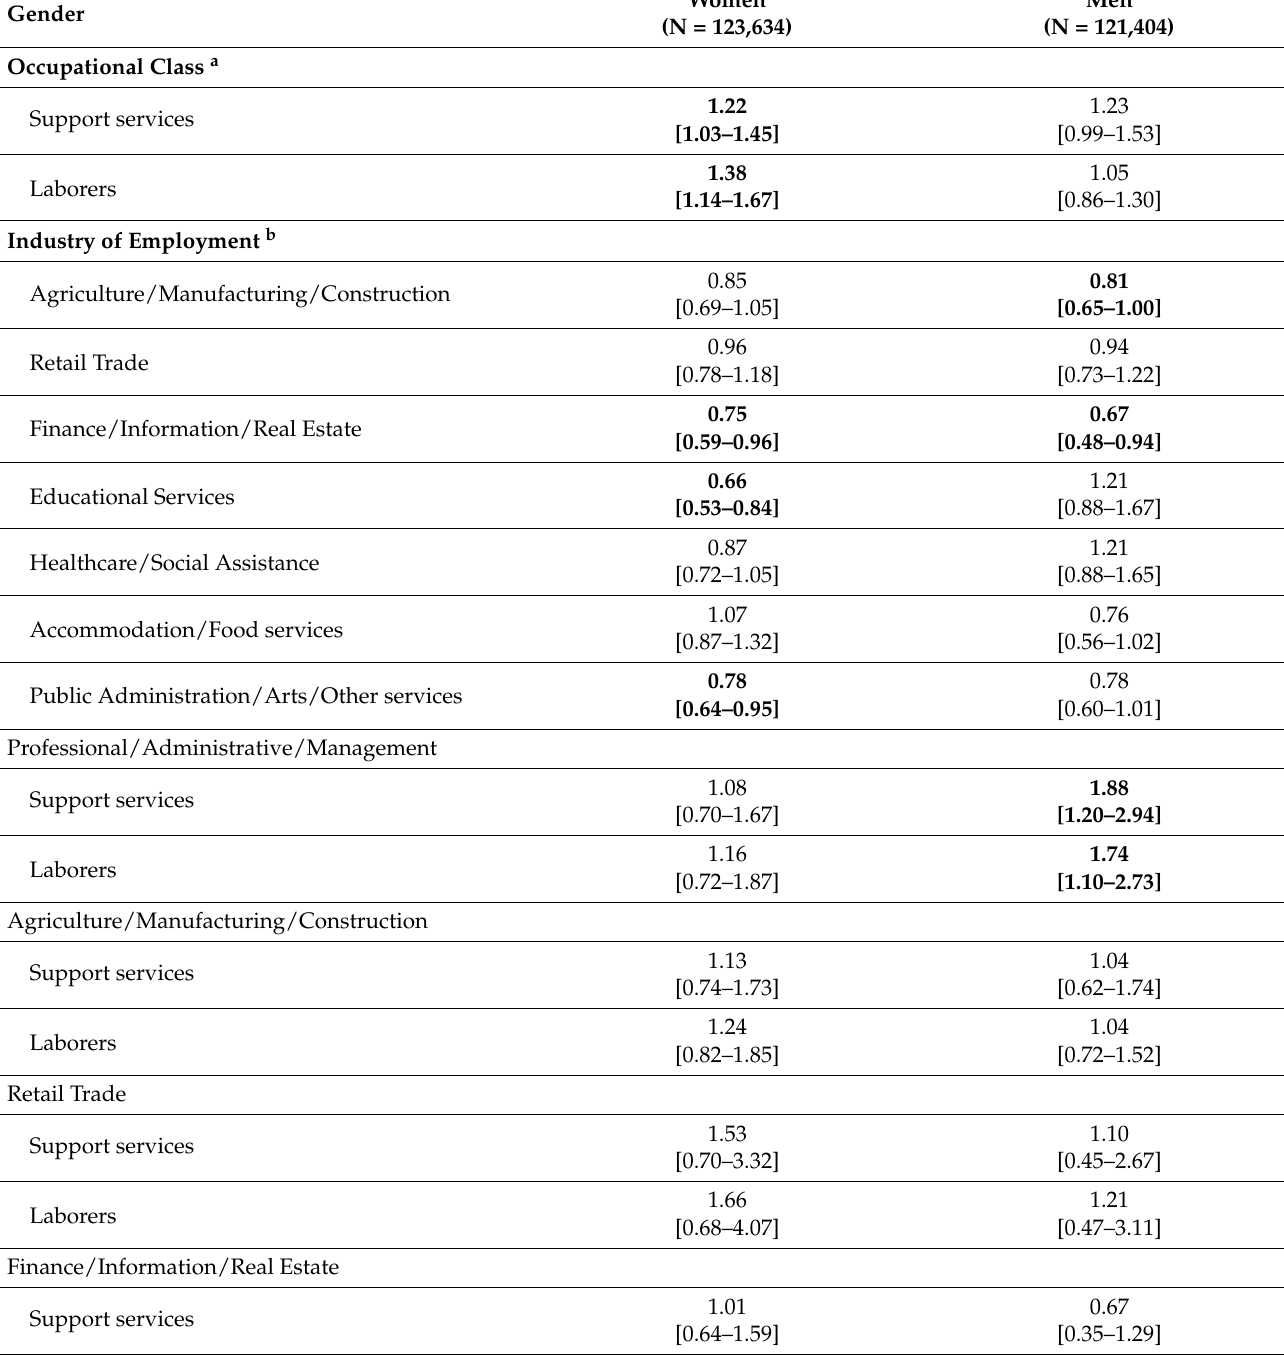
Table 3. Adjusted Prevalence Ratios (95% Confidence Intervals) for the Association Between Oc- cupational Class (compared to Professional/Management positions) and Industry of Employment (compared to the Professional/Administrative/Management Industry) and Serious